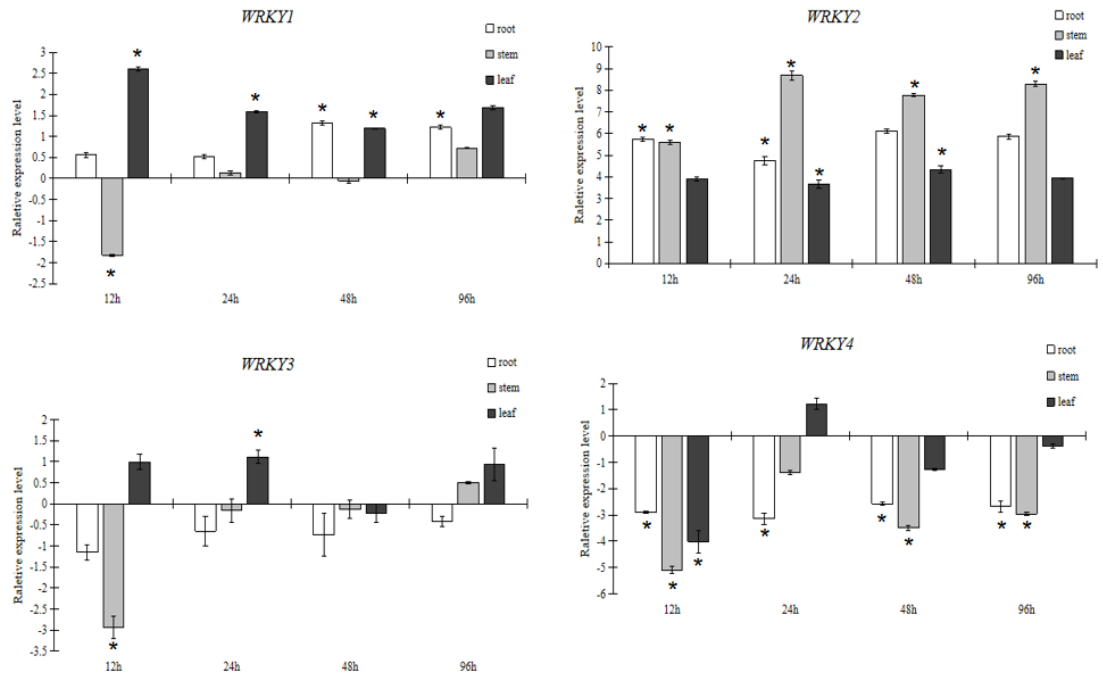
Figure 6. Gene expression levels at 0.2 mol/L NaCl solution treatment at different times. Note: * * indicates a significant indicates a significant difference.